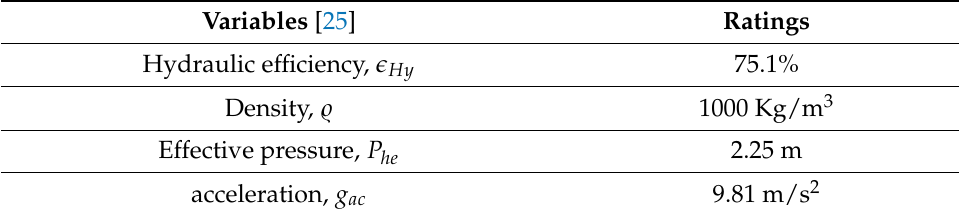
Table 3. Parameters of